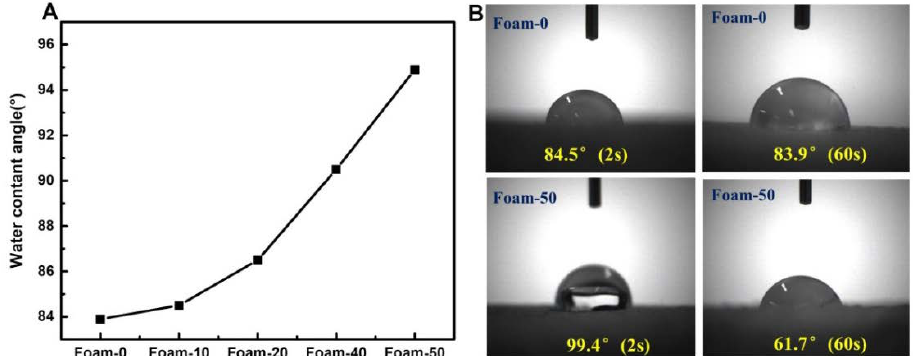
Figure 3. ( A ) Water contact angles of composite foams; ( B ) Water contact angles of Foam-0 and Foam-50 at 2 s and 60 s.